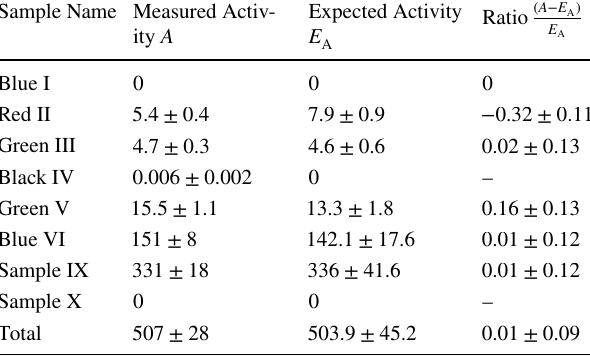
Table 3 Comparison between measured activity, A, and calculated E expected activity, A , in Bq, assuming >99% efficiency for throughout the volume reduction process